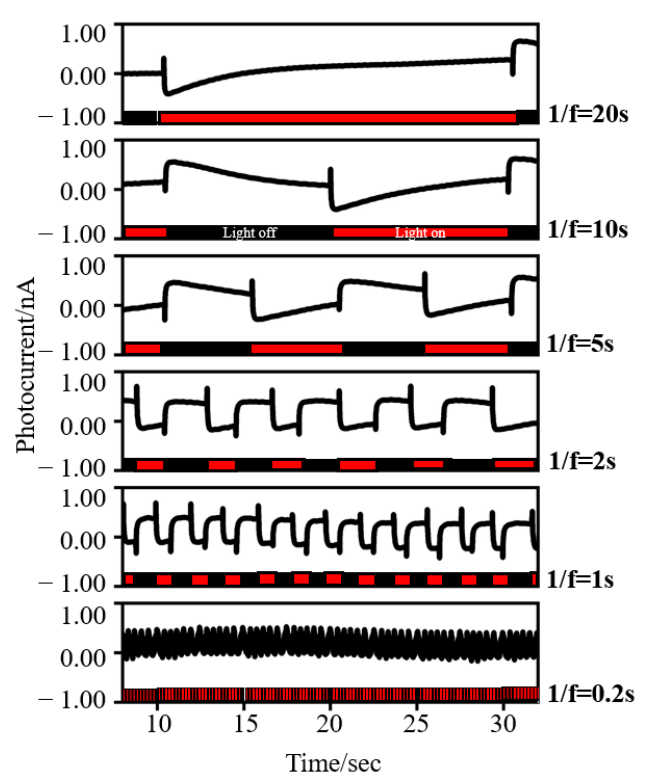
Figure 4. The photocurrent waveform changes with the light flickering frequency. f represents the flickering frequency of the induced light. flickering frequency of the induced